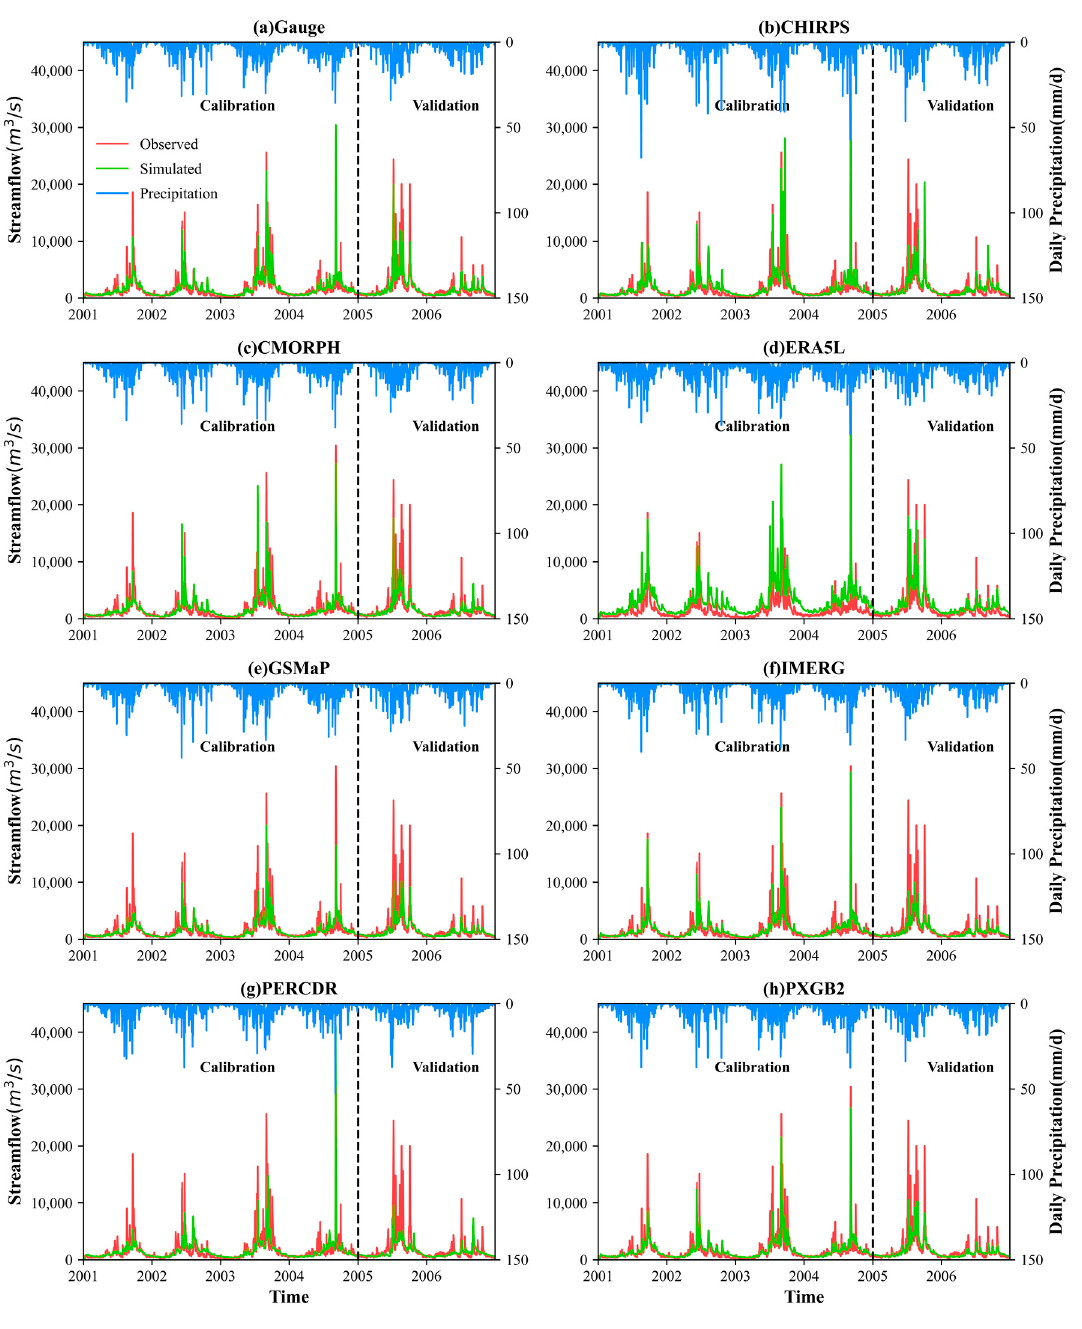
Figure 6. Comparison of observed and BTOP simulated daily streamflow using gauge observations and seven MSPs in calibration and validation periods under scenario I.